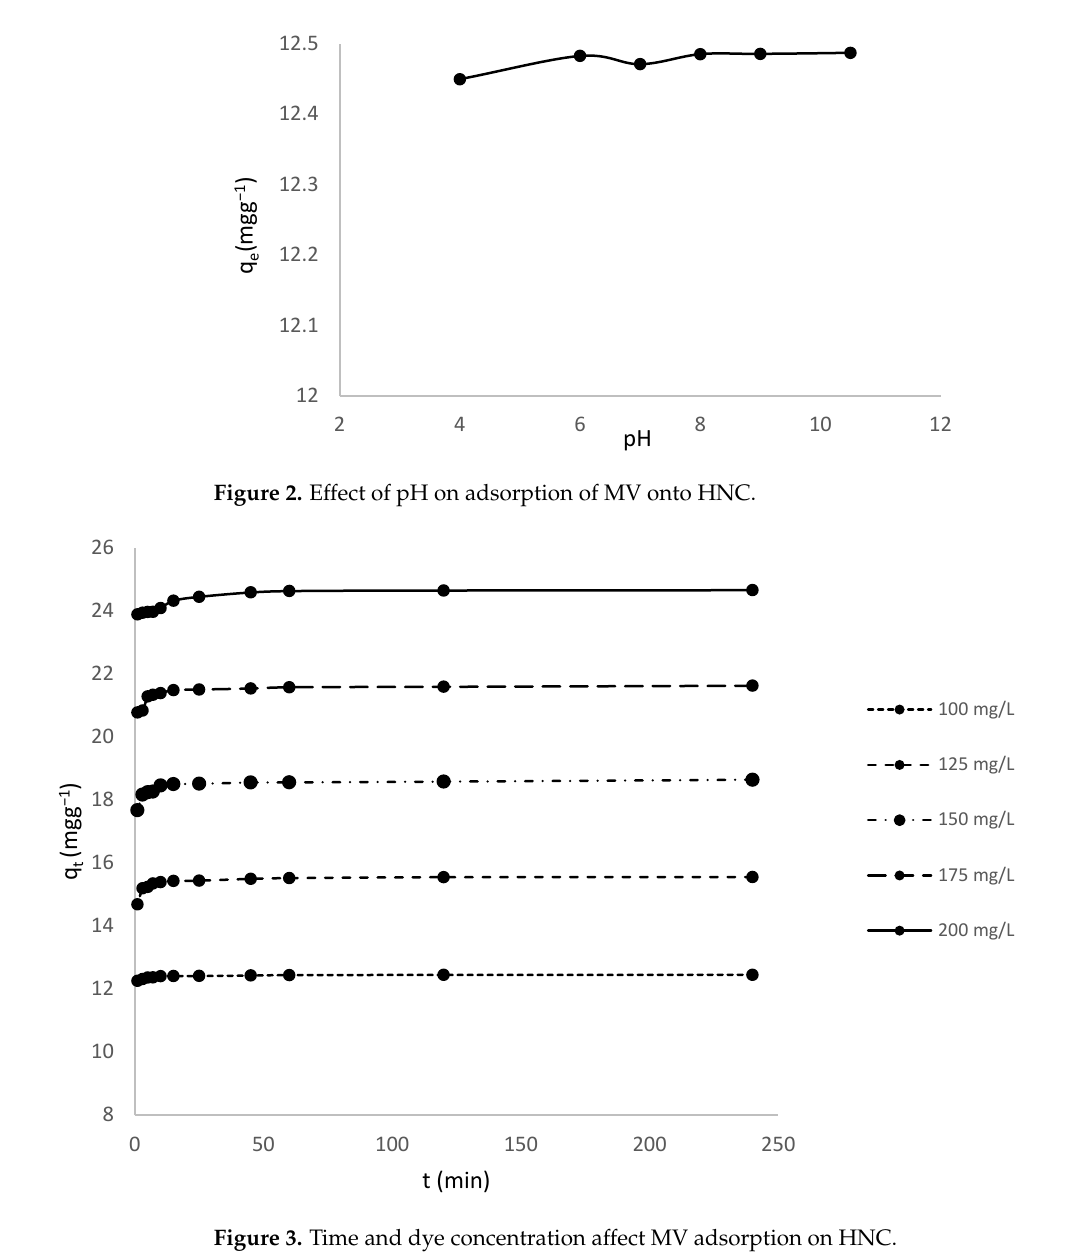
Figure 3. Time and dye concentration affect MV adsorption on HNC.